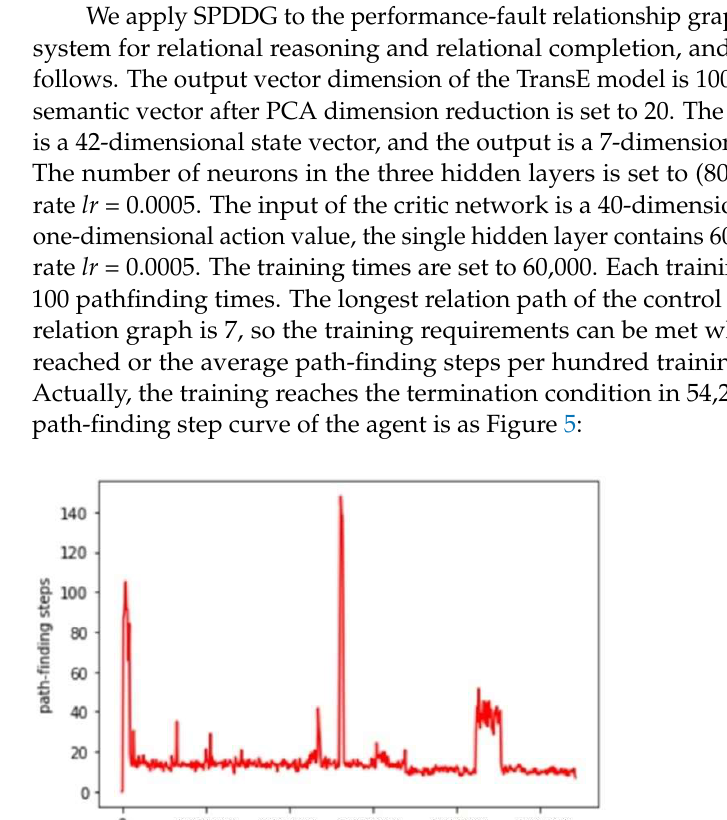
Figure 4. Performance-fault relationship graph of spacecraft control system.